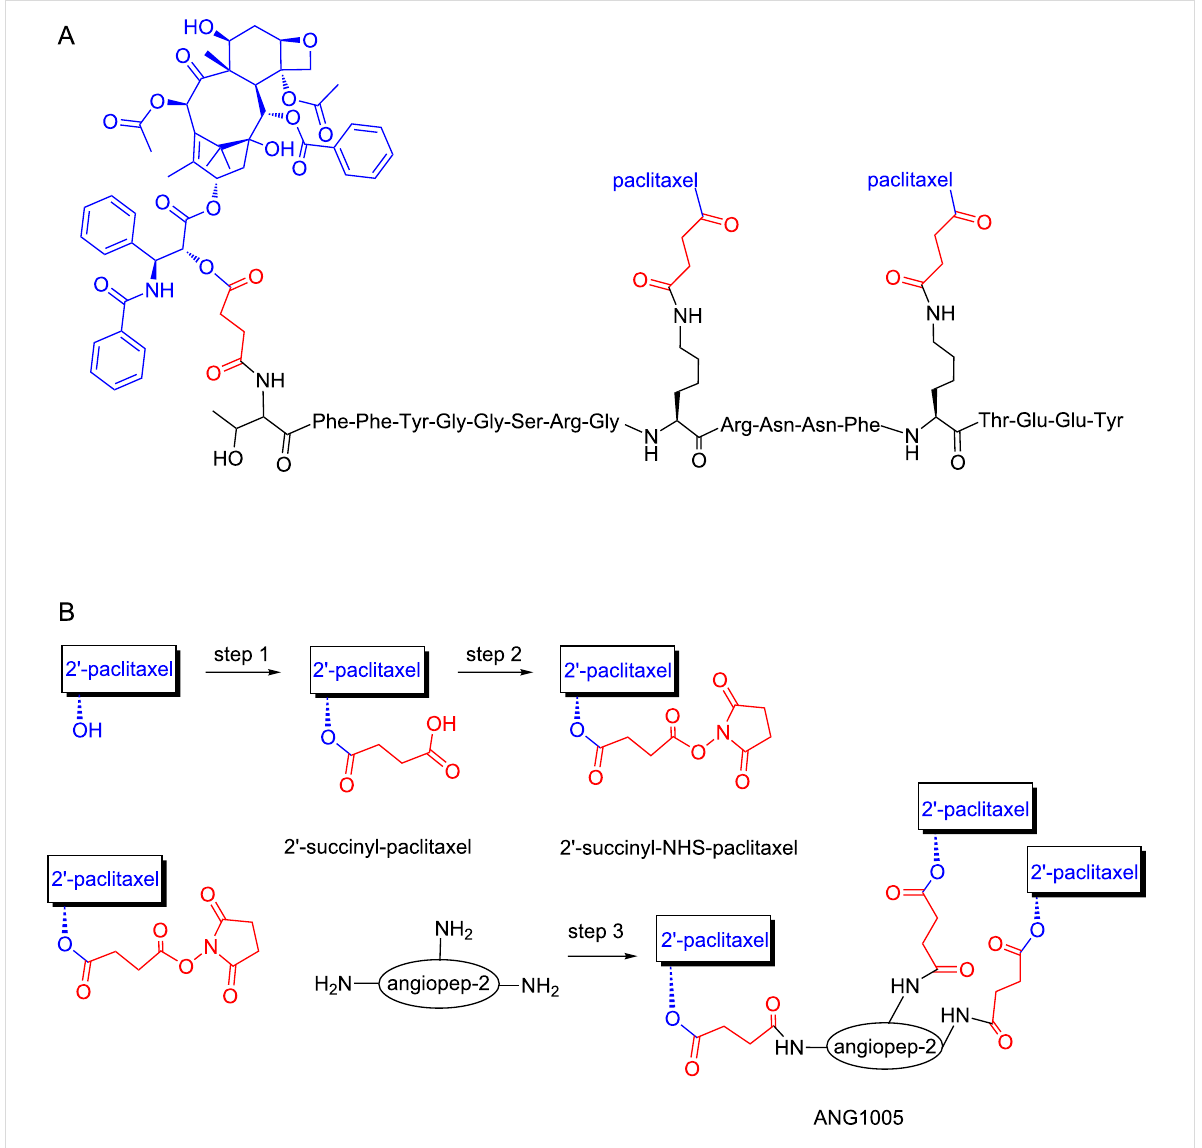
Figure 8: Chemical structure and synthetic scheme for the PDC ANG1005. (A) ANG1005 is composed of three molecules of paclitaxel linked by a cleavable succinyl ester linkage to the angiopep-2 peptide. (B) Schematic representation of ANG1005 synthesis steps. Paclitaxel was first reacted with succinic anhydride and then activated with N -hydroxysuccinimide to form 2 ′ -succinyl-NHS-paclitaxel in two steps. In the conjugation step (step 3), amines of the angiopep-2 peptide react with 2 ′ -succinyl-NHS-paclitaxel. The scheme was modified according to Br. J. Pharmacol. 2008, 155, 185–197